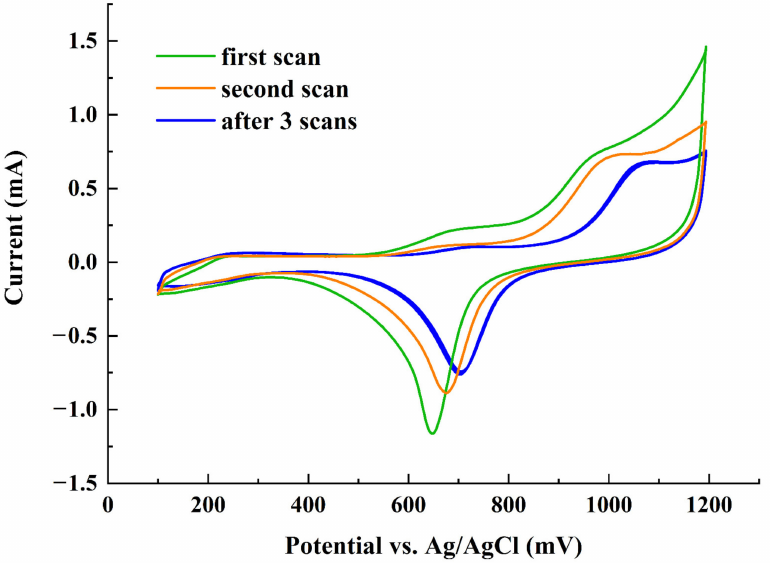
Figure 3. In situ cyclic voltammograms of PGF Au in 10 mM phenol + 0.1 M H 2 SO 4 at 50 mV/s. Potentials were quoted against the